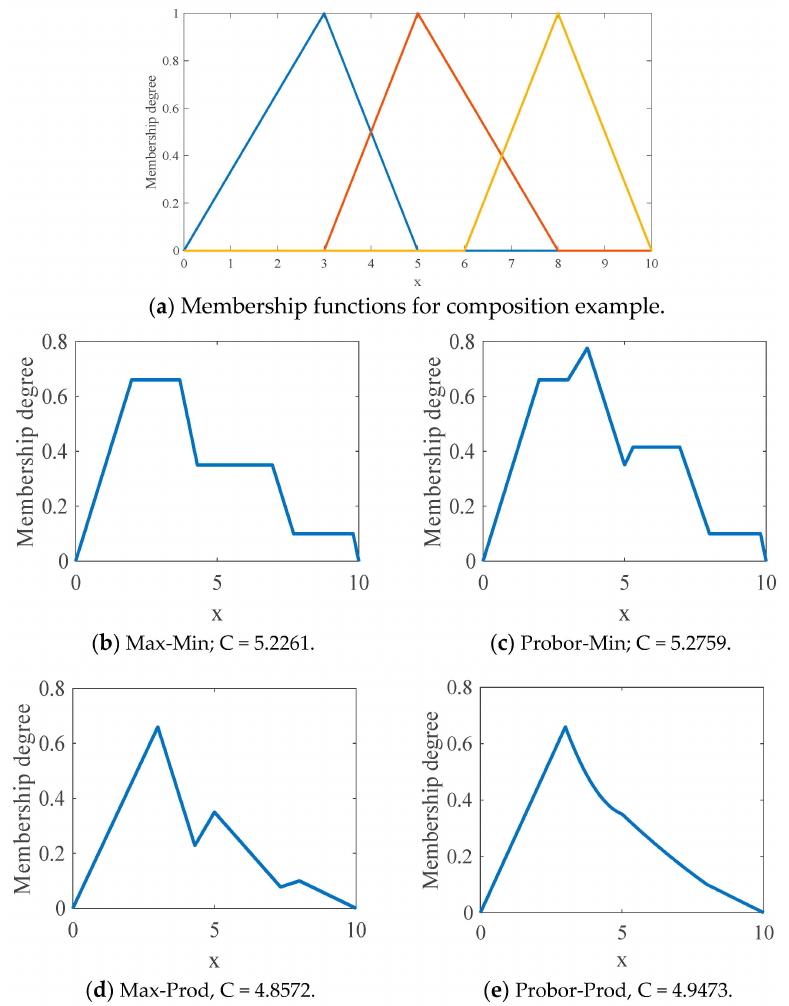
Figure 3. Different types of composition operators.